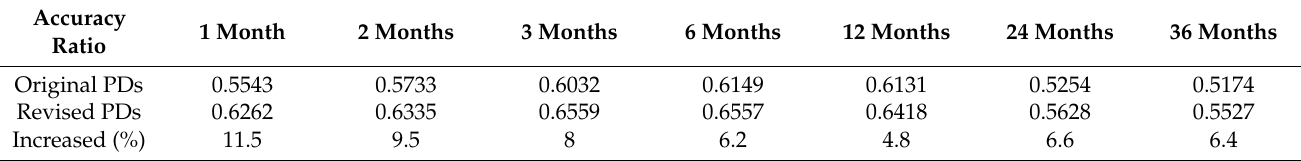
Table 7. Comparison of the ARs out of sample